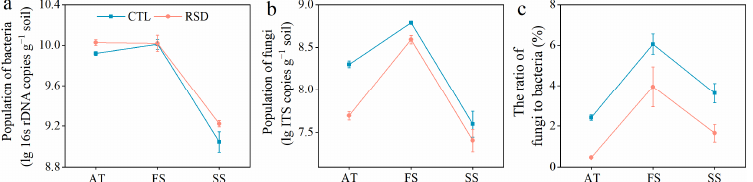
Figure 1. Populations of bacteria ( a ) and fungi ( b ) and the ratio of fungi to bacteria ( c ). Error bars represent the standard errors (SE S ). CTL, untreated soil; RSD, soil incorporated with molasses, irrigated to saturation, and covered with plastic film. AT, FS, and SS indicate the soils collected from after treatment, the first season, and the second season,